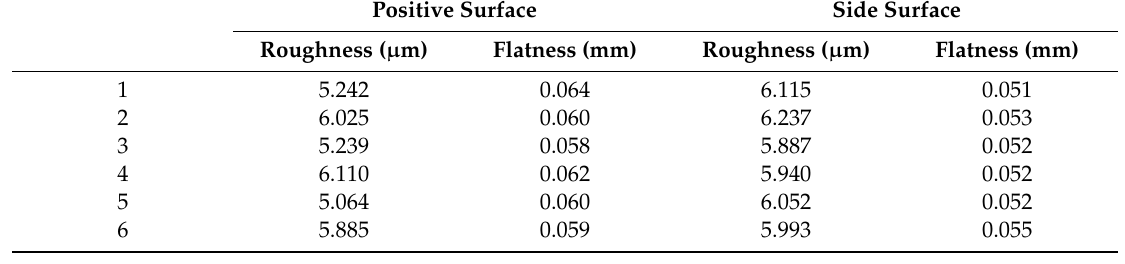
Figure 9. New scan strategy used in this study. Table 5. Surface quality on the inner structure printed using the modified scan strategy.